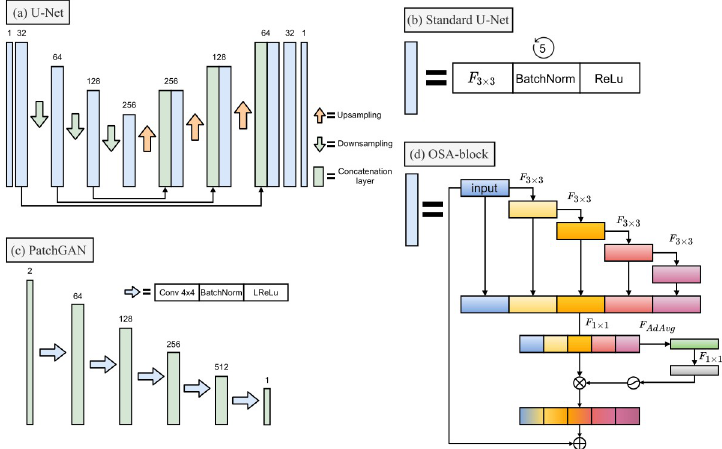
Fig 2. Diagrams of ANN architectures used in this study. (a) U-Net, a standard encoder/decoder architecture, which our image-to-image generator models are based on. Each upsampling uses bilinear interpolation to double image size and each downsampling uses max pooling to half image size. (b) The standard U-Net convolutional block, which contains a 3x3 convolution ( F 3 ), batch normalization (BatchNorm) and standard ReLu. (c) PatchGAN, which × 3 comprises the discriminator of our CGAN-based models. The two channels in the first PatchGAN-layer indicate the input z-sweep image stacked onto the corresponding z-projection, either predicted or measured. Each arrow indicates a convolutional block containing a convolution with a 4x4 kernel and stride of 2 (Conv 4x4), batch normalization (BatchNorm) and leaky ReLU activation function with alpha = 0.2 (LReLU). (d) One-shot aggregation (OSA) block, and F 1 adapted from [27], which replaces the standard U-net block in our improved U-Net variants. Here, F 3 × 3 × 1 indicate 3x3 and 1x1 convolutional layers, F AdAvg adaptive average pooling over spatial dimensions, � indicate followed by the 1 × 1 convolution and the hard element-wise multiplication and � element-wise addition. F AdAvg Sigmoid activation make up the efficient Squeeze-and-Excitation (eSE)-module of the OSA-block. Note that F 1 × 1 projects the concatenated tensor to the same dimensions as input tensor and that the element-wise multiplication is performed along the channel-axis and broadcasted over the spatial dimension.